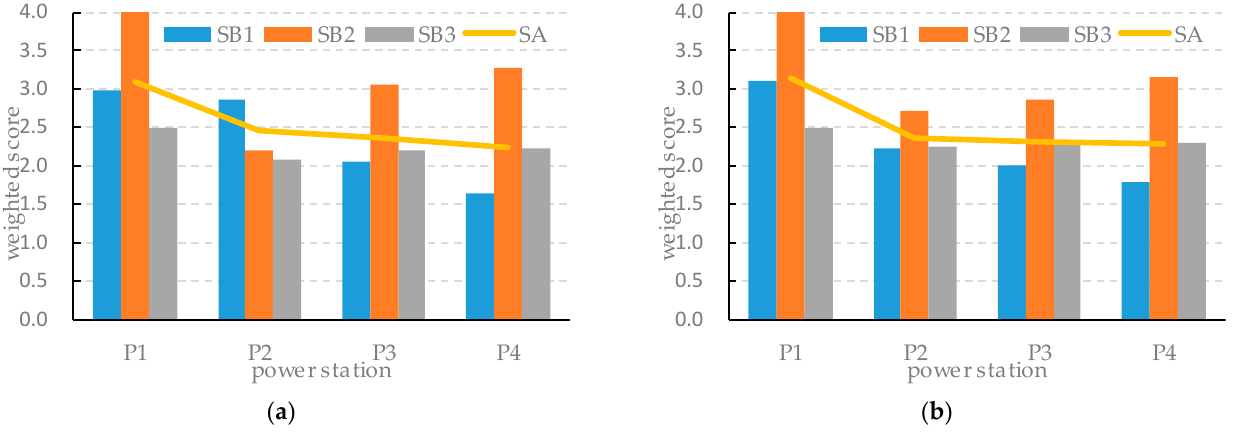
Figure 3. Weighted scores of primary and overall indicators based on different methods. ( a ) Evaluate results based on improved G1 Method. ( b ) Evaluate results based on entropy weight method.